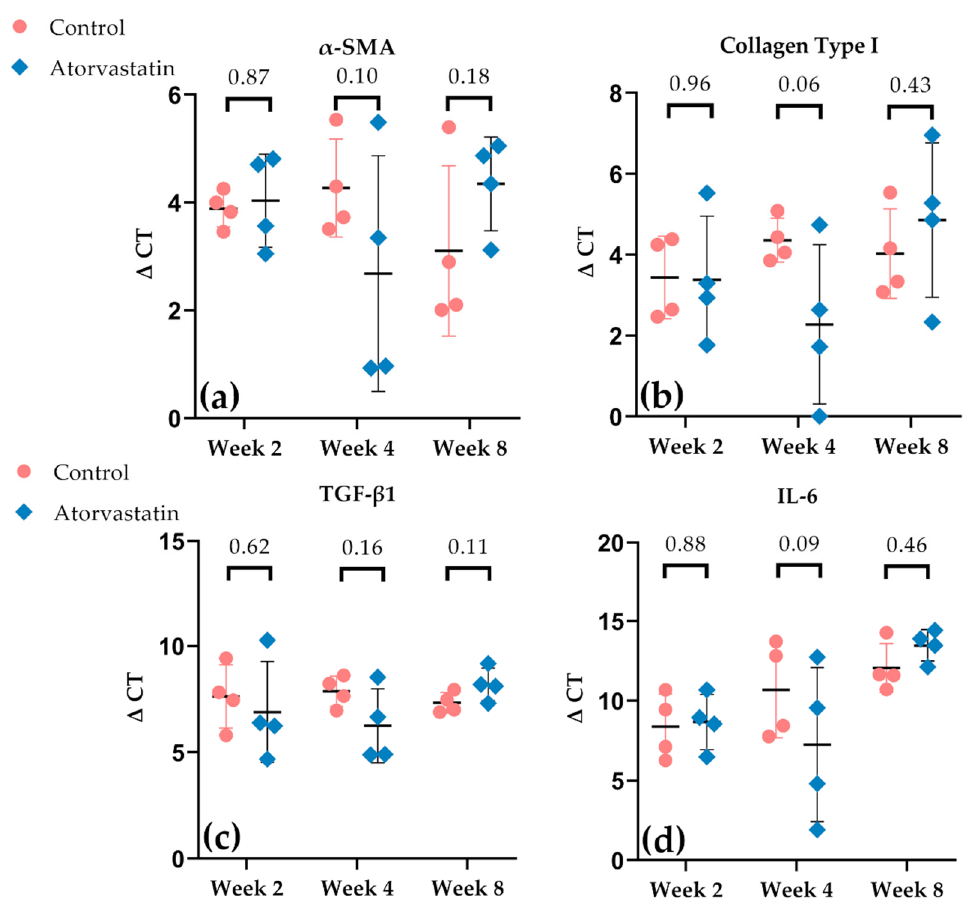
Figure 9. Gene expression of α -SMA ( a ), collagen type I ( b ), TGF- β 1 ( c ) and IL-6 ( d ) is depicted as Δ Ct values in scatter dot blot design with mean and SD. Differences between atorvastatin and control are expressed as p -values above the scatter dots.